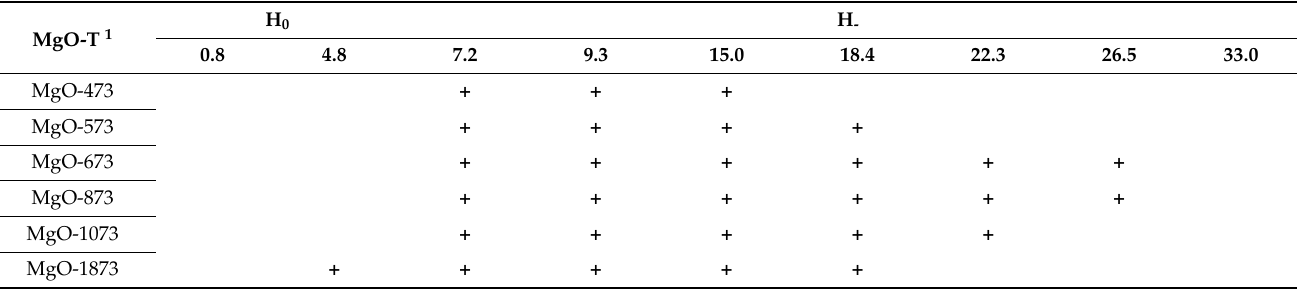
Table 3. Distribution of the strength of acidic and basic sites on the surface of MgO-T samples determined using the Hammett indicator